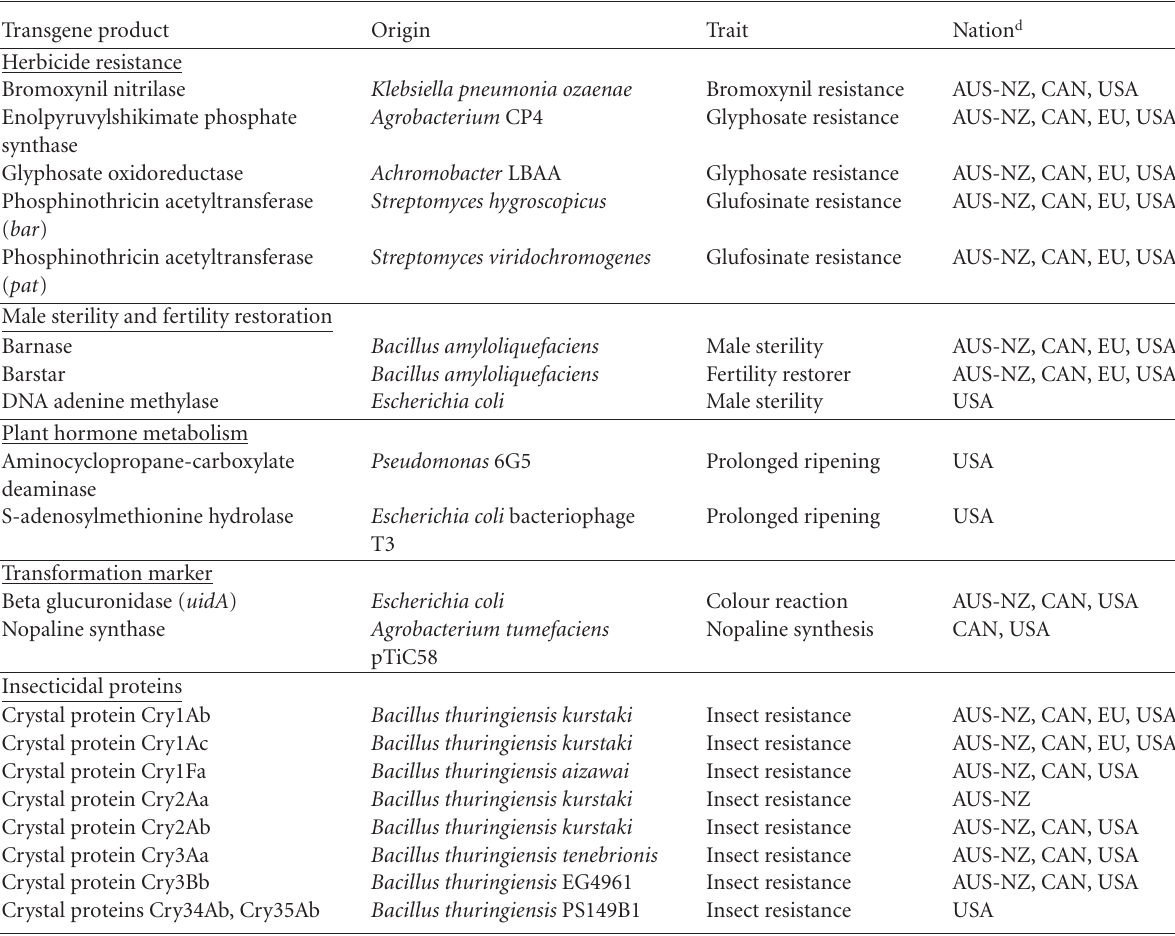
Table 1. Microbial transgenes in GM crops that have been approved for human food use a,b,c